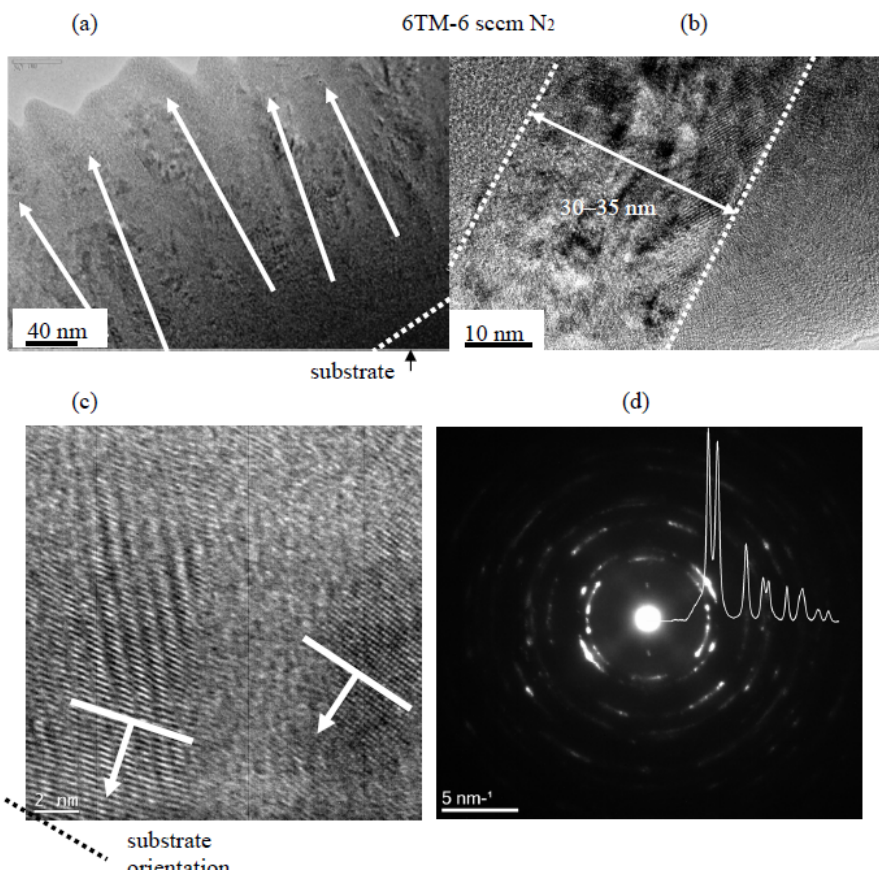
Figure 6. TEM structure of reactive HiTUS TiNbVTaZrHf-6N coating deposited with 6 sccm N 2 : ( a ) low magnification image demonstrating slightly disoriented columnar grains approximately perpendicular to the substrate embedded in the amorphous matrix phase; ( b ) HRTEM of the columnar grain and ( c ) FFT enhanced image of the columnar grains and ( d ) corresponding SAED and its azimuthal integral.